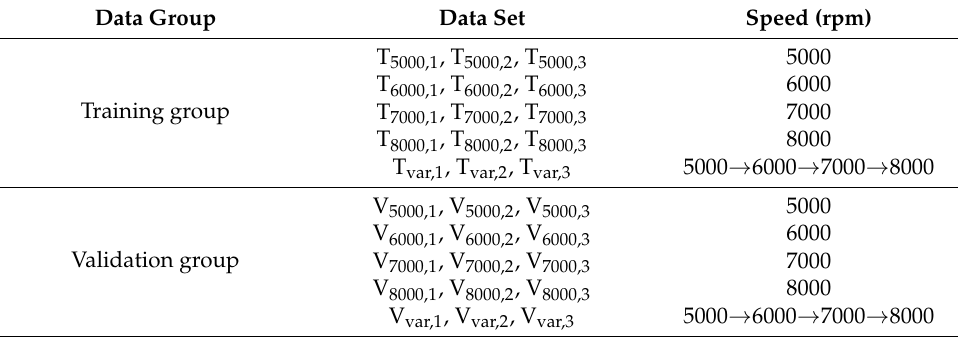
Table 2. The list of the training and testing data sets. Data Group Data Set Speed (rpm)